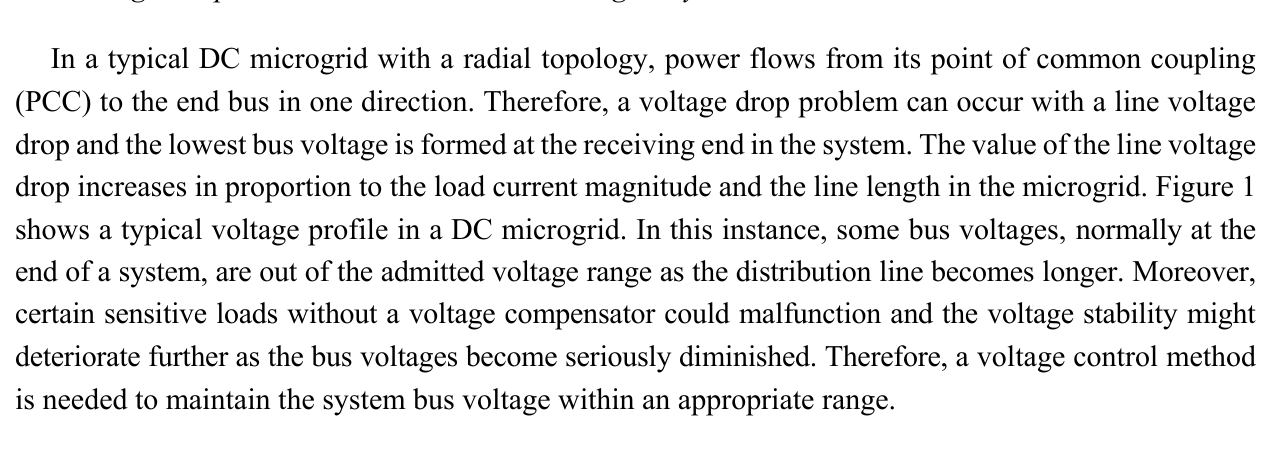
Figure 1. Voltage profile in a DC